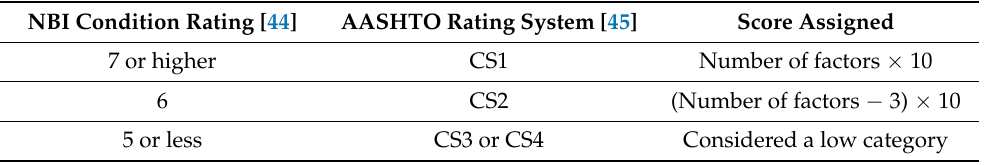
Table 1. Initial score assigned for bridge component based on the rating system and number of performance and consequence (P&C) factors.